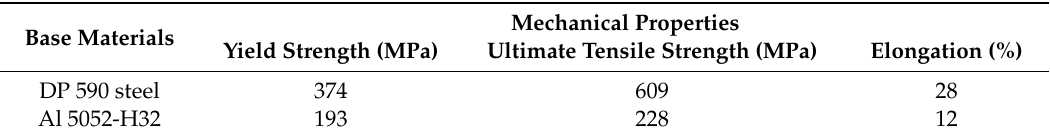
Table 1. Mechanical properties of base